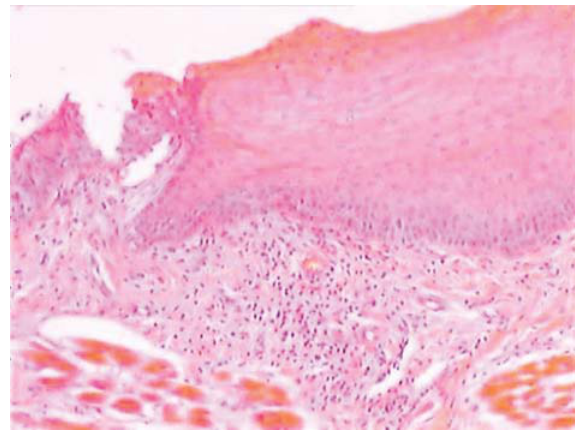
Figure 2 – The buccal mucosa graft one week after surgery. (cid:36)(cid:3)(cid:80)(cid:82)(cid:71)(cid:72)(cid:85)(cid:68)(cid:87)(cid:72)(cid:3)(cid:76)(cid:81)(cid:191)(cid:79)(cid:87)(cid:85)(cid:68)(cid:87)(cid:76)(cid:82)(cid:81)(cid:3)(cid:82)(cid:73)(cid:3)(cid:83)(cid:82)(cid:79)(cid:92)(cid:80)(cid:82)(cid:85)(cid:83)(cid:75)(cid:82)(cid:81)(cid:88)(cid:70)(cid:79)(cid:72)(cid:68)(cid:85)(cid:3)(cid:70)(cid:72)(cid:79)(cid:79)(cid:86)(cid:3)(cid:90)(cid:68)(cid:86)(cid:3)(cid:82)(cid:69) - served.